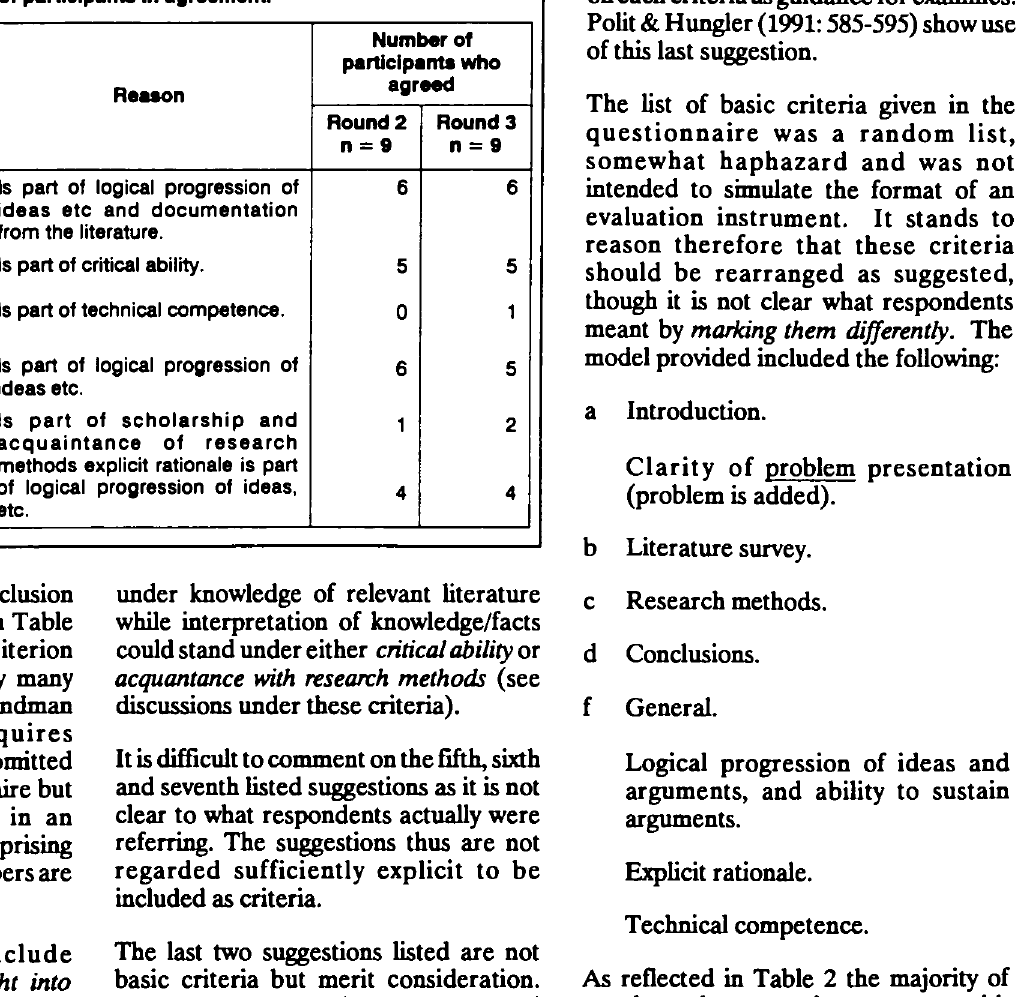
Table 1 Suggested deletions from list of basic criteria, reasons and number of participants In